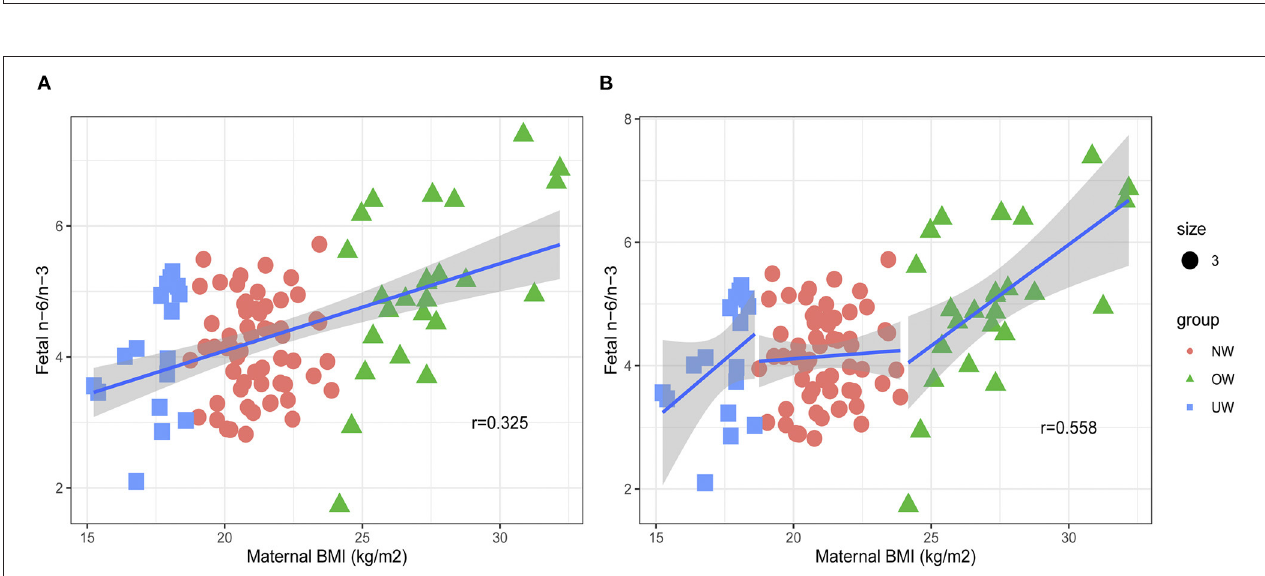
FIGURE 3 | Associations between maternal pre-BMI and fetal n-6/n-3. (A) The association between maternal pre-BMI and fetal n-6/n-3 in all subjects. (B) The association between maternal pre-BMI and fetal n-6/n-3 in different groups.